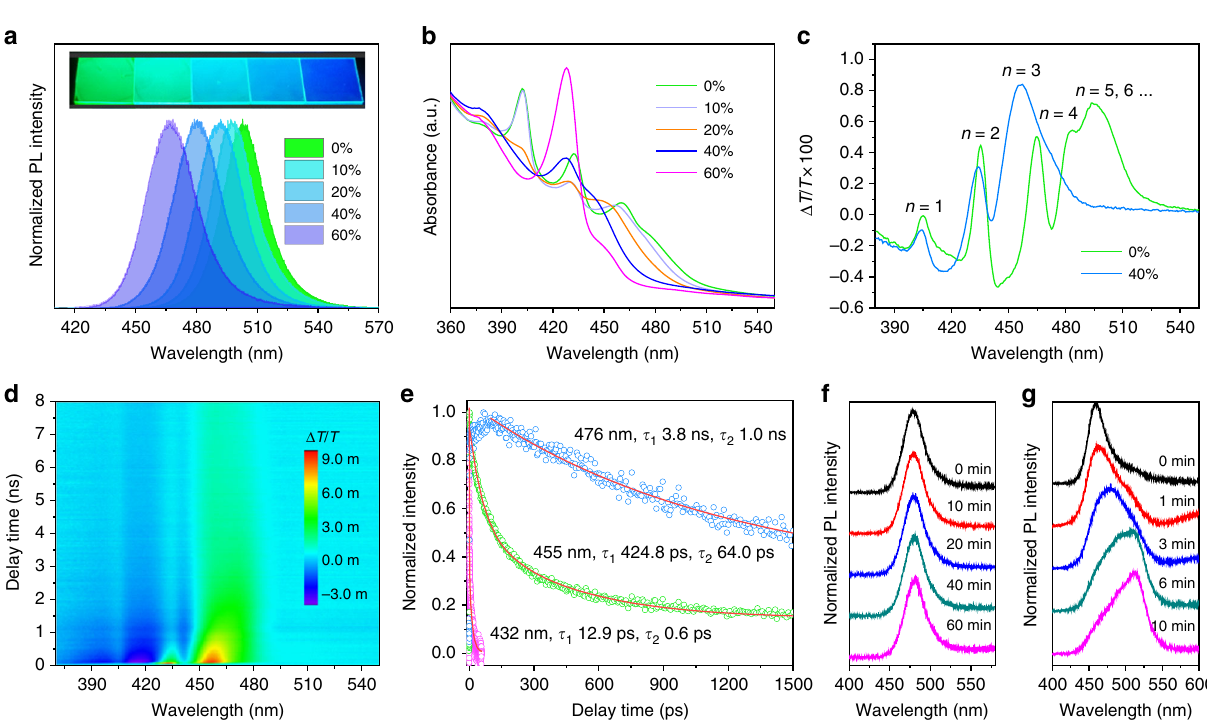
Fig. 2 Photophysical properties of quasi-2D perovskite. a PL and b absorption spectra of perovskite PEA 2 A 1.5 Pb 2.5 Br 8.5 with 0 − 60% IPABr additive. The inset is a photograph of the corresponding fi lms under 365 nm UV irradiation. c TA spectra of PEA 2 A 1.5 Pb 2.5 Br 8.5 with 0 and 40% IPABr. d , e TA time delay of PEA 2 A 1.5 Pb 2.5 Br 8.5 with 40% IPABr. PL spectra of quasi-2D perovskite ( f ) and MAPbCl 1.5 Br 1.5 ( g ) fi lm under continuous laser radiation (325 nm, 7 W cm − 2 ) for different exposure X-ray diffraction (XRD) results reveal the layered structure of UV − Vis absorption spectra were used to characterize the formed perovskite thin fi lms (Supplementary Fig. 2). Diffraction optical bandgap and excitonic features of these perovskites. In peaks at 4.35, 8.74, 13.5, 27.2, and 31.55 degrees correspond to the Fig. 2b, multiple excitonic absorption features at 3.1, 2.9, 2.7, and (0 0 l ) series of Bragg re fl ections of the quasi-2D perovskite. The 2.6 eV correspond to the perovskite phases with n = 1, 2, 3, and 4, lowest angle of 4.35° corresponds to the lattice fringe of 2.0 nm, respectively 28 . We also observed a blueshift of the absorption edge of the perovskite fi lms with increased IPABr fraction. We attribute this blueshift to the fact that the component of lowest- n and highest- n phases was inhibited gradually, while the inter- mediate n phase ( n = 2, 3, 4) grew faster instead (Fig. 2b). spectra of the perovskite fi lms. Pristine PEA 2 A 1.5 Pb 2.5 Br 8.5 per- ovskite emits at 504 nm; the addition of IPABr progressively